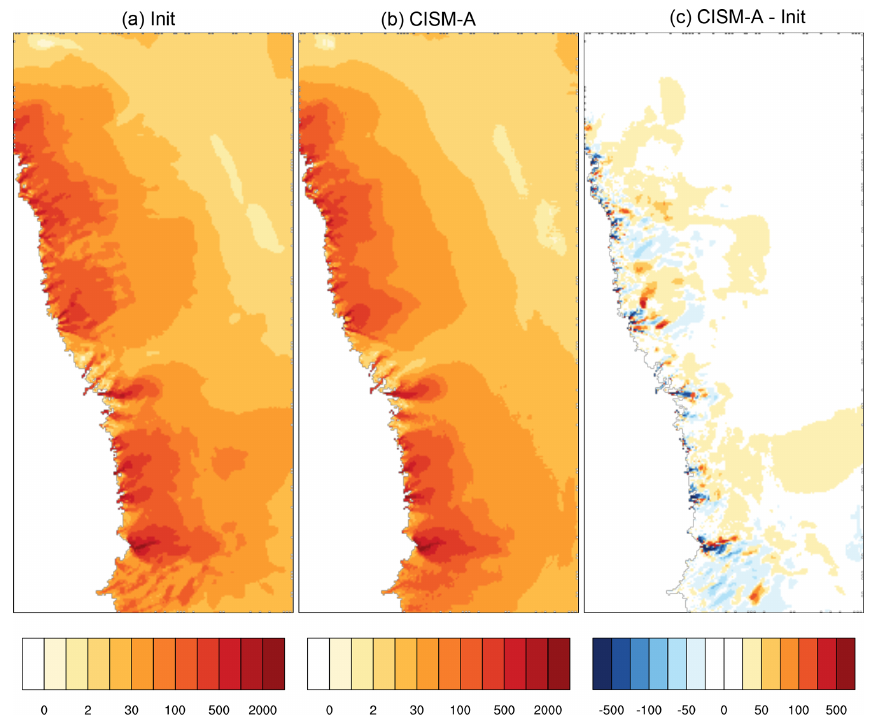
Figure 4. The norm of the surface velocity field (ms − 1 , given by the color bars) from initialization (Joughin et al., 2010a, b) (a) , CISM-A (b) , and the difference (c) over drainage basins 7 and 8 as indicated by Fig. 1.